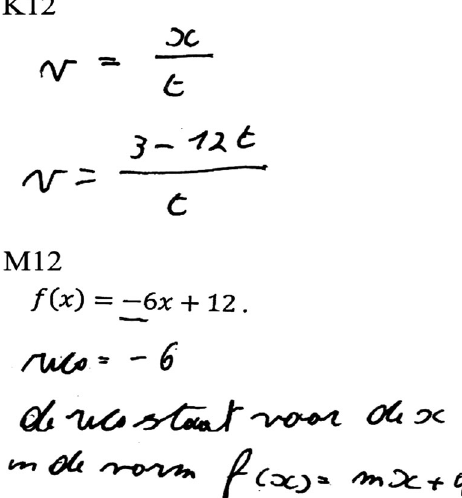
FIG. 9. Example of case 2 with question K12 in which the equation x ¼ 3 – 12 t was provided: an algebraic interval or pointconfusioninwhichtheequationofmotionissubstitutedinthe formula for velocity. Additionally, the isomorphic question M12 from the same student is shown, in which strategy S1 is used: the location of − 6 is underlined in the question and the explanation translates as “ the slope is located before the x in the form f ð x Þ ¼ mx þ q .